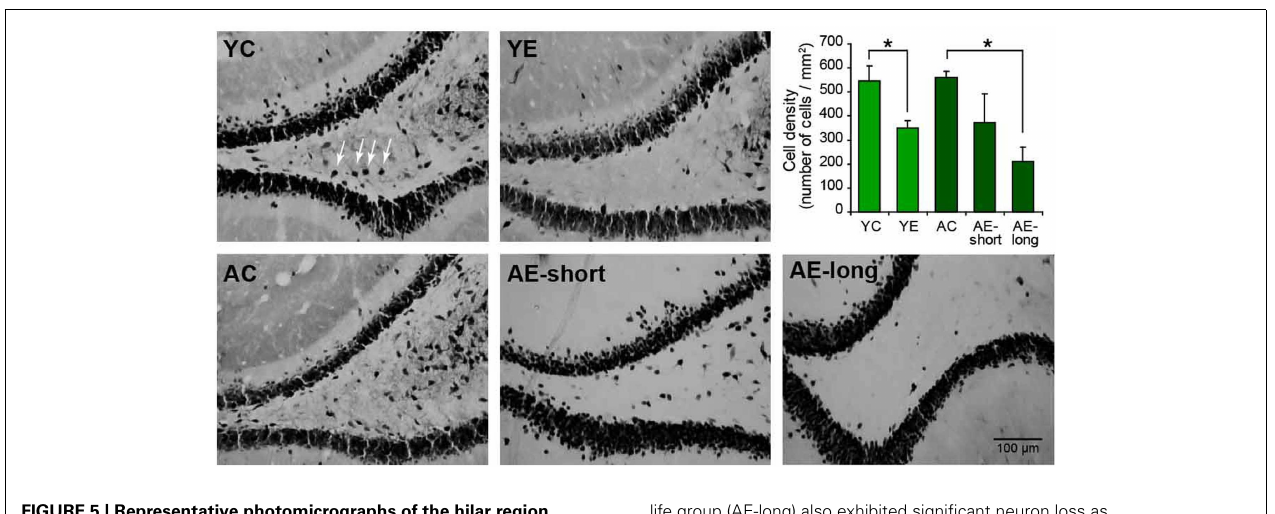
FIGURE 5 | Representative photomicrographs of the hilar region of the DG of the hippocampus stained for NeuN .The graphic shows the quantification of NeuN-positive cells in the hilus.The young-epileptic group (YE) exhibited significant neuron loss compared to the young-control group. Among aged animals, the long epileptic